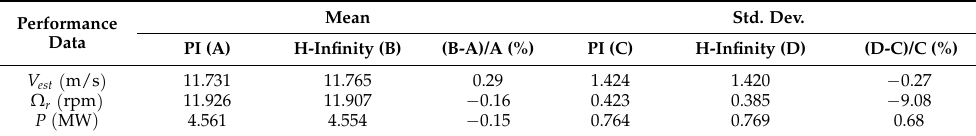
Table 4. Comparison of NTM results for performance data in 12 m/s noisy environment.